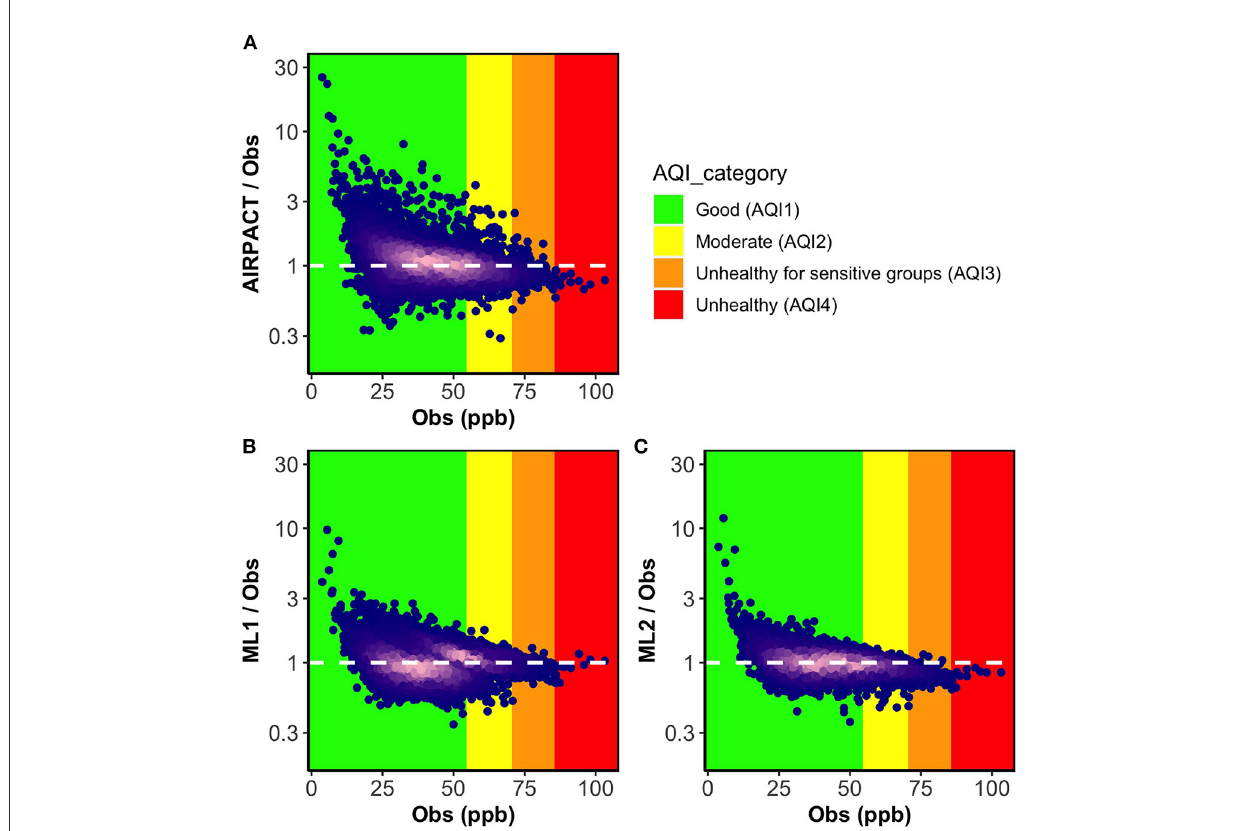
FIGURE1 Ratio plots of model predicted MDA8 O 3 to observations vs. observations for three models (A) AIRPACT, (B) ML1, and (C) ML2. The point color of dark blue to bright pink indicates density of the data increasing. The white dashed lines mark the ideal condition (the ratio between model predictions and observations is 1). The ratio below 1 represents the model under-prediction and the ratio above 1 represents the over-prediction.